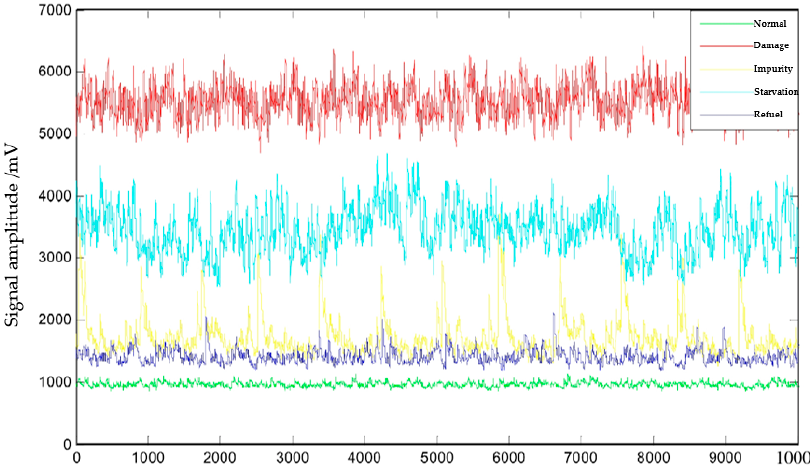
Figure 21. Waveforms of ultrasonic signals on different operation conditions (Adapted from [184]).